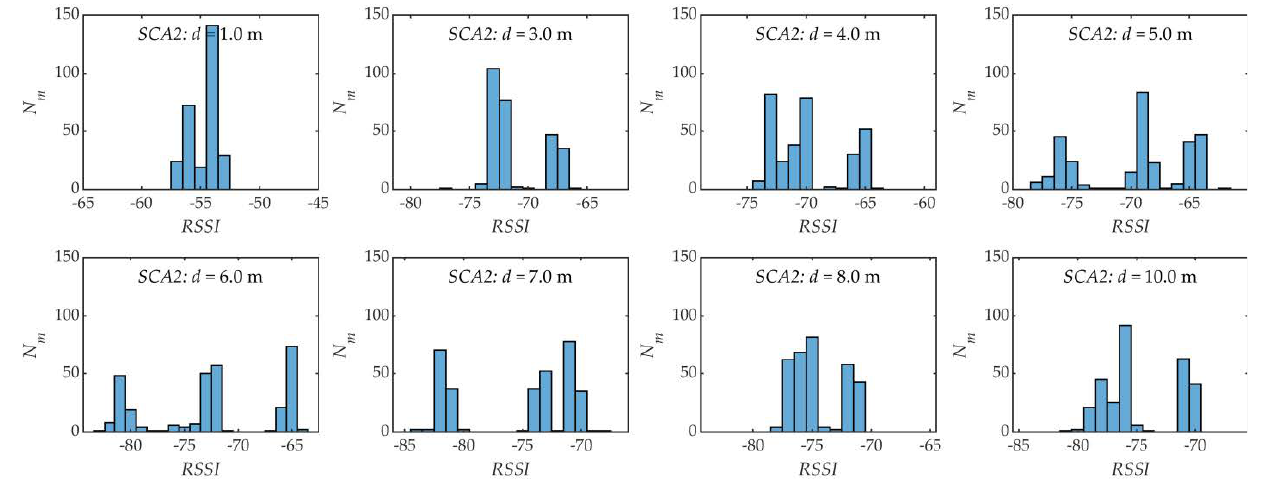
Figure 8. Histograms of the distribution of RSSI values for measurement points at different distances d from LocA2 for the SCA2 test scenario.